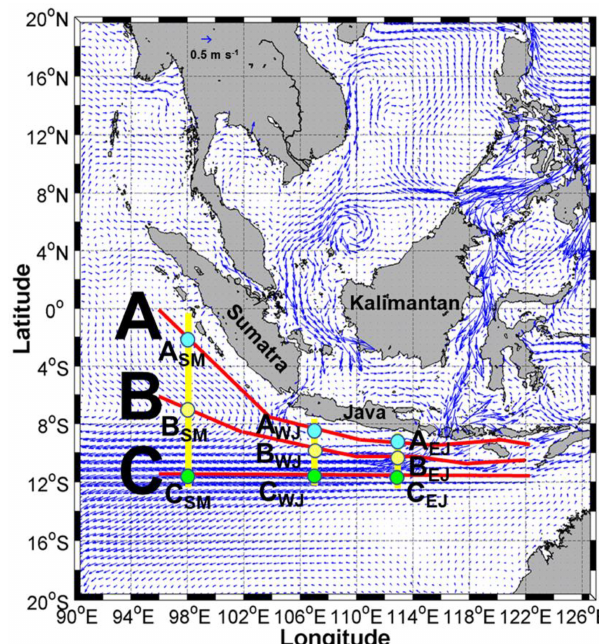
Figure 2. The area of study interest in the SETIO region adjacent to the Sumatran and Javan southern coasts. The blue arrows show cli- matological (yearly mean) surface (1m) current field over 64 years from 1950 to 2013. Yellow lines are the meridional sections along the three longitudes (98, 107, and 113 ◦ E), while red lines are the three selected transects: A, B, and C. Green, yellow, and cyan circles are the locations in which the zonal currents are analyzed, namely points A SM , A WJ , A EJ (on Transect A); points B SM , B WJ , and B EJ (on Transect B); and points C SM , C WJ , and C EJ (on Transect C). The subscripts SM, WJ, and EJ denote regions which are close to Sumatra, West Java, and East Java,